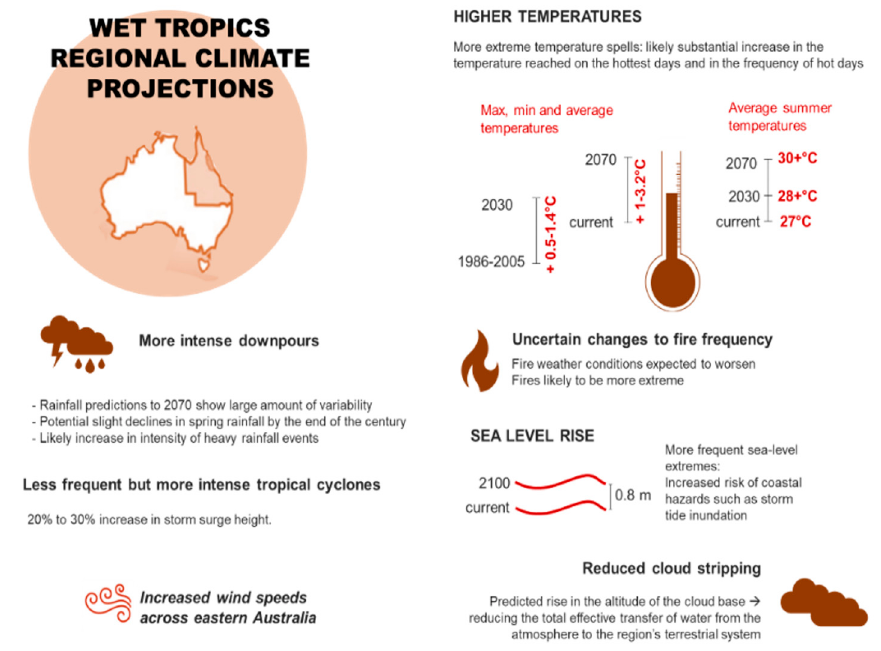
Figure 4. Wet Tropics regional climate projections. Data source [13].